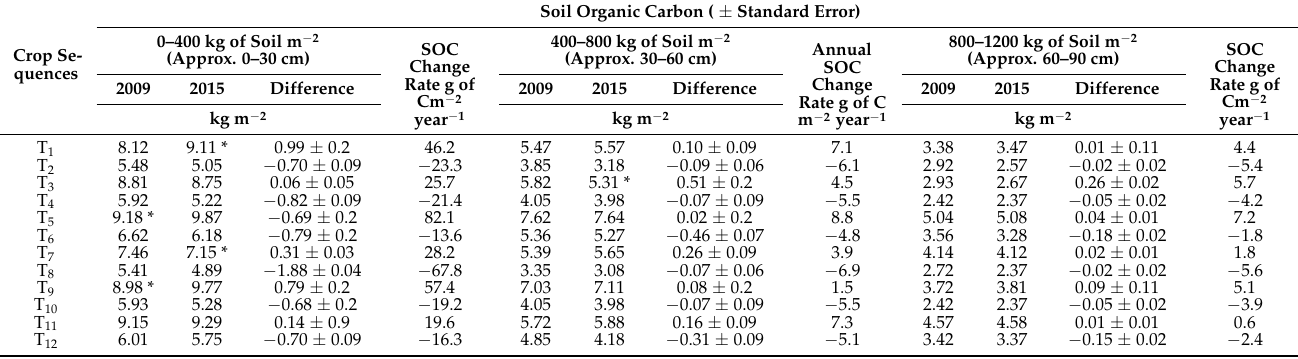
Table 6. Annual rate of change in multiple soil mass intervals and variations in SOC stocks from (averaged over alternative cropping systems and precision land leveling practices) 2009 and in 2015.